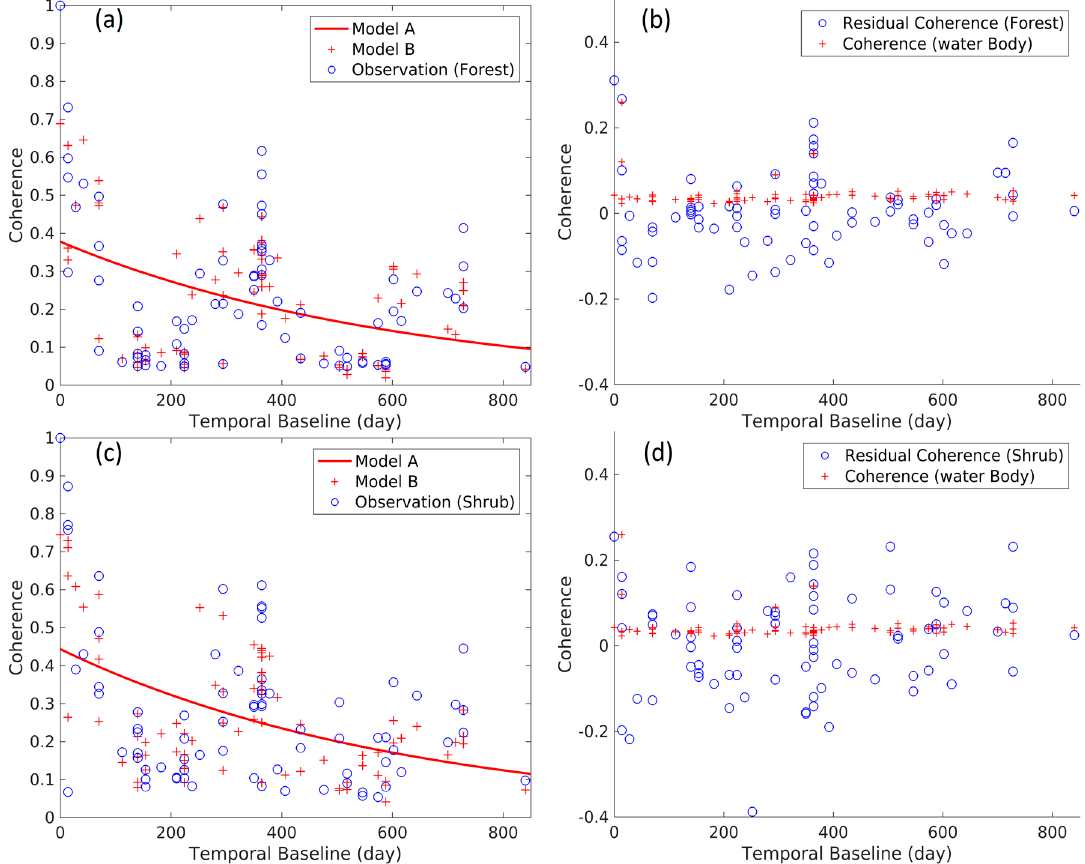
Figure 4. Scatter plots of observations and model B for forested ( a ) and shrub ( c ) land cover types. Scatter plots of residual coherences (observation—model B) for forested ( b ) and shrub ( d ) land cover types. Plot of model A and the scatter plot of coherence of water body are shown for comparison. Table 2. Model parameters of the two land cover types. Cf is the critical f